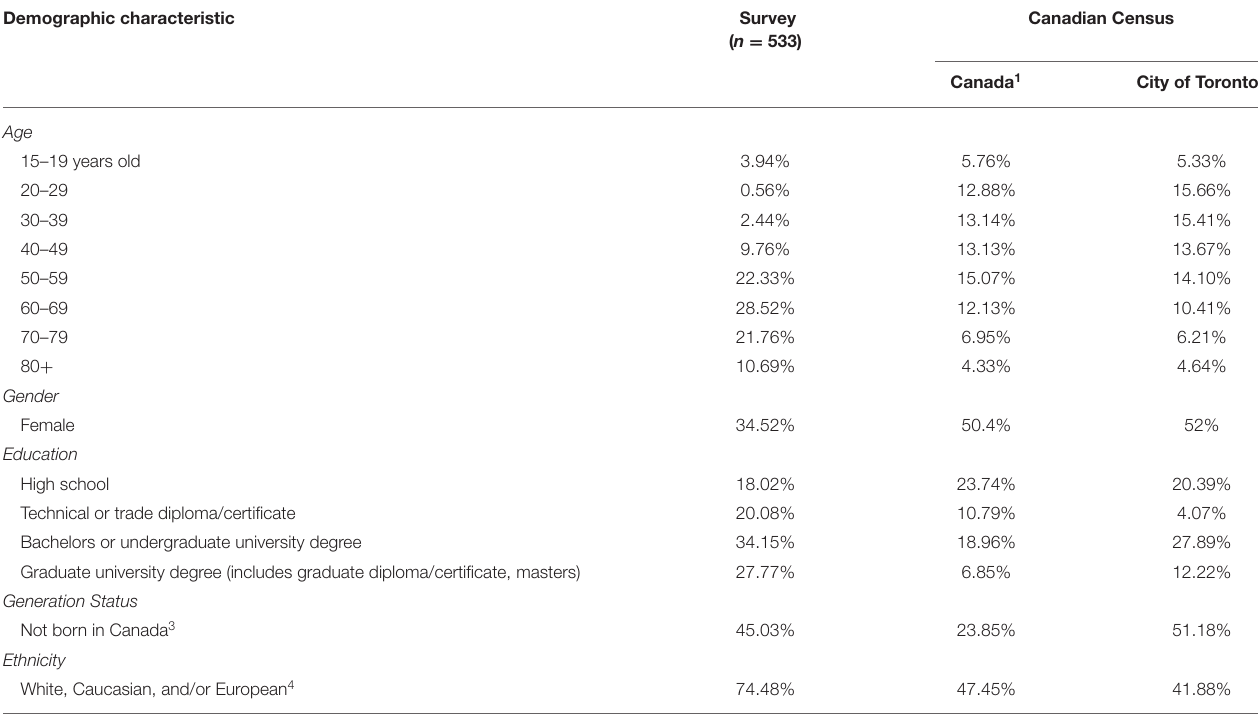
TABLE 2 | Participant sample